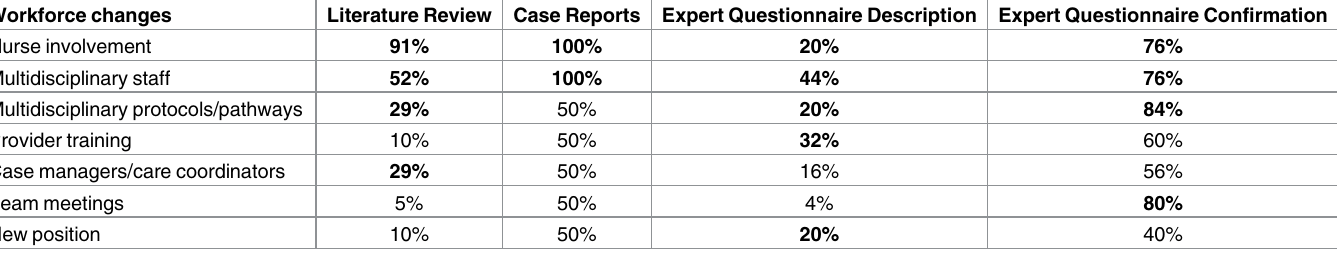
Table 7. Overview of the workforce changes among the highest three percentages in the literature review or expert questionnaires, or present in both case reports. Workforce